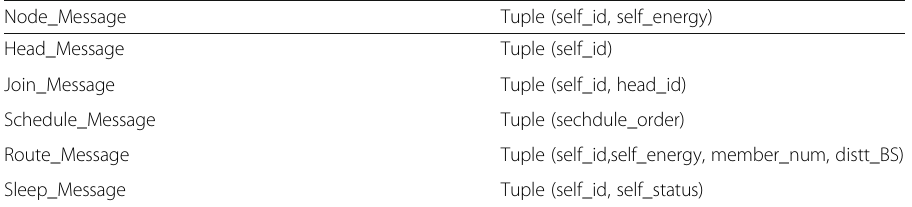
Table 2 Control messaging in